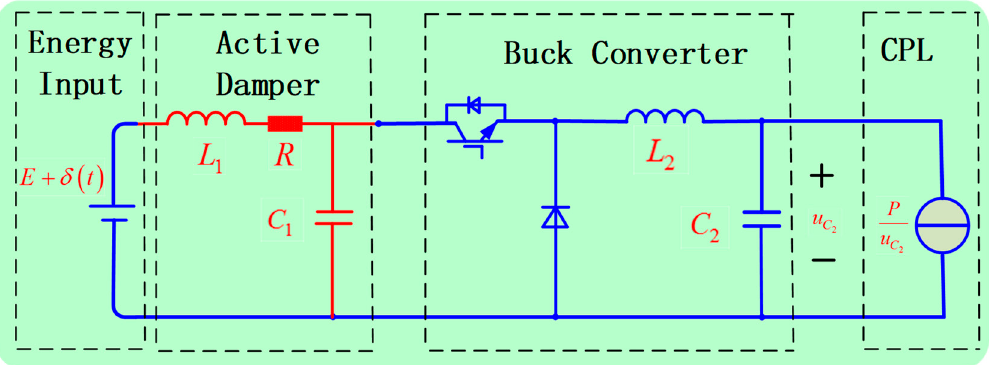
Figure 3. The proposed active damping circuit of the DC microgrid.